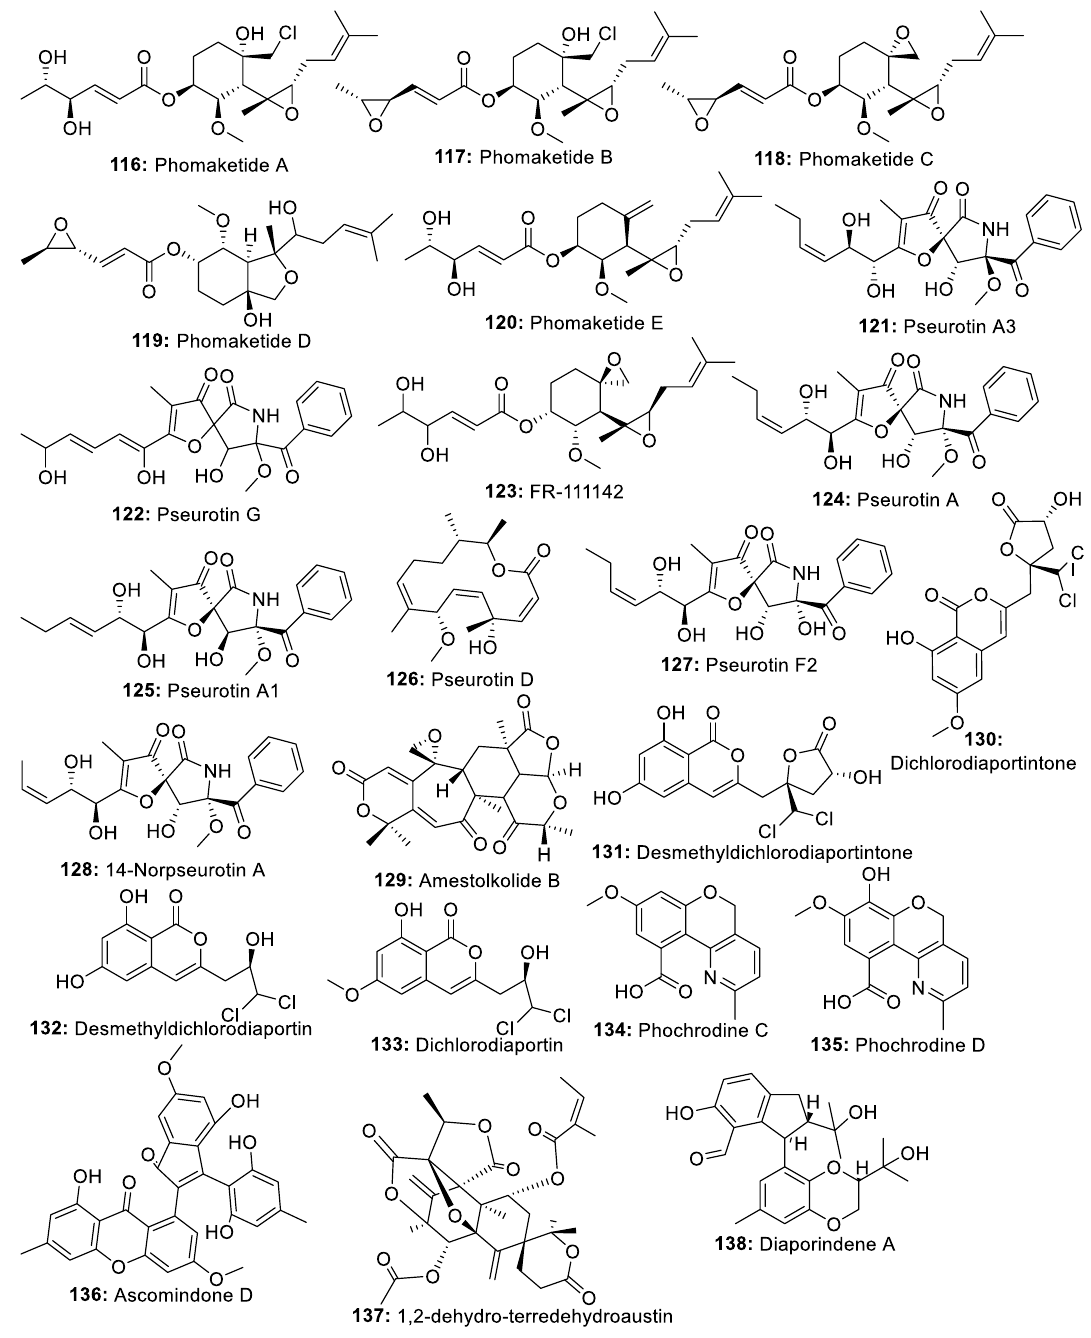
Fig. 4 Selected active metabolites produced by endophytic fungi from marine